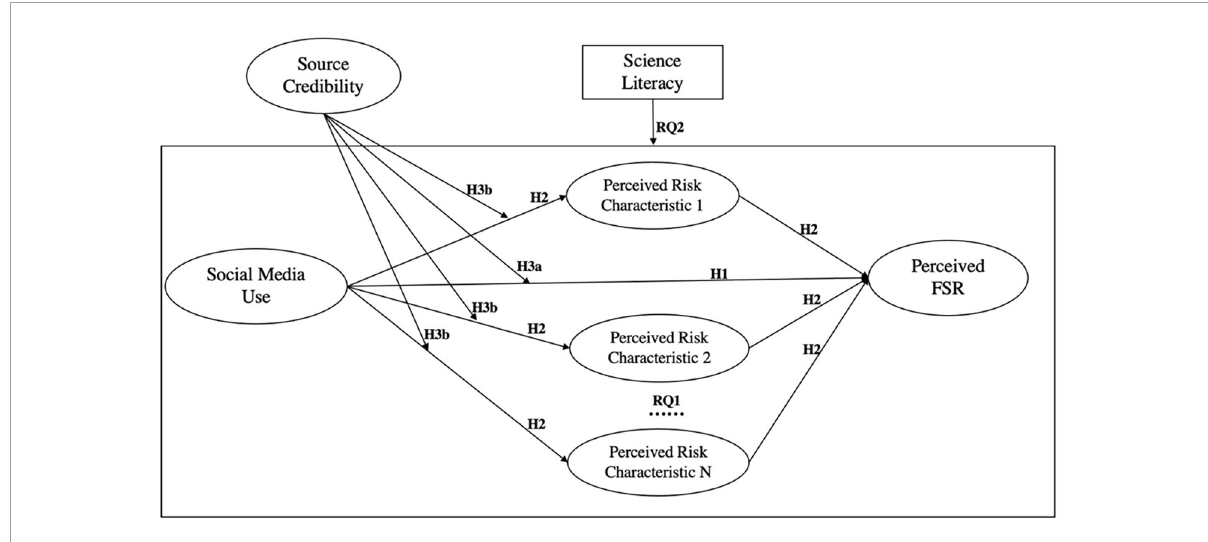
FIGURE1 Conceptual